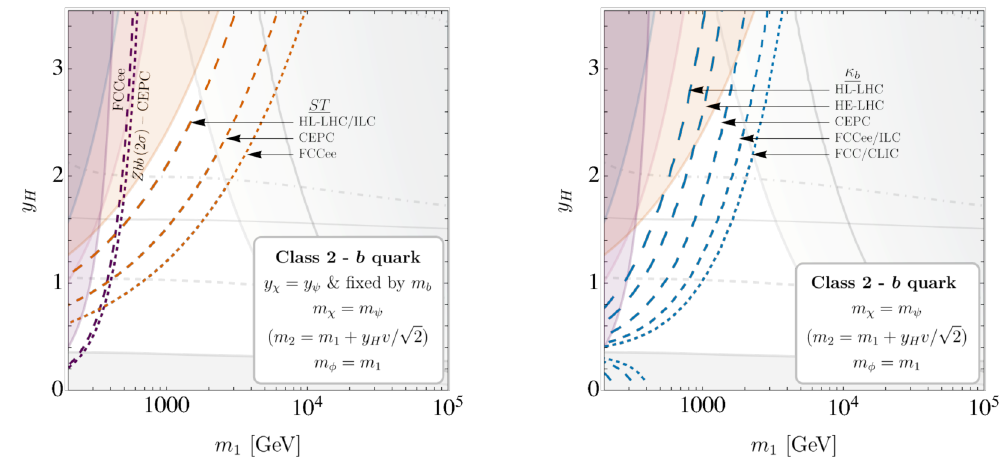
Figure 13. Projected 2 σ experimental sensitivities on the Class 2 b -quark benchmark model from future colliders, for the left slice of parameter space in fig.